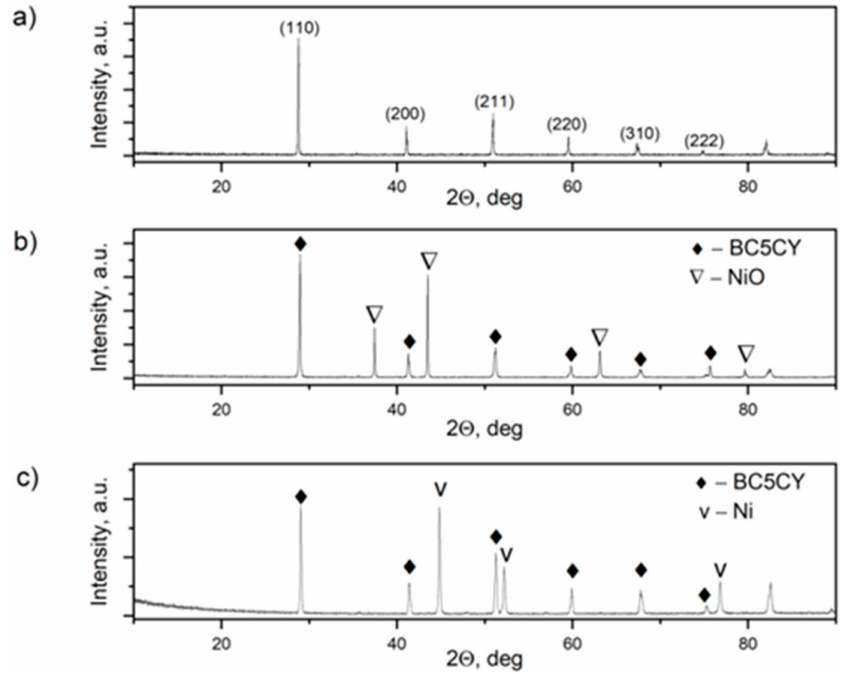
1550 ◦ C for 2 h and the Ni–5CBCY sample following reduction at 700 ◦ C for 2 h in 10 vol.% H 2 in Ar.